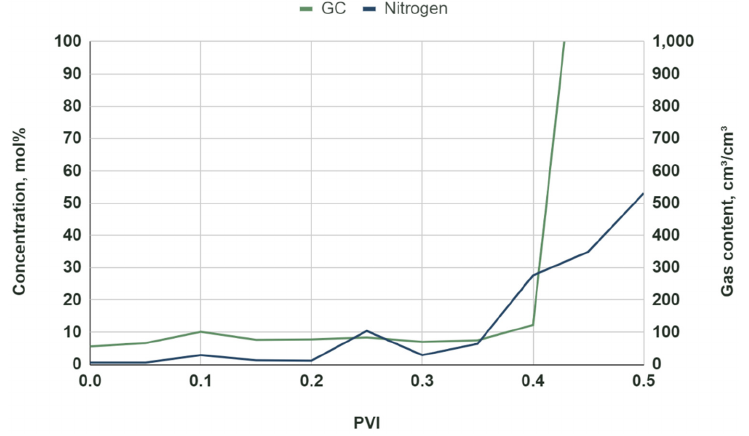
Figure 8. Nitrogen concentration in produced gas, for Nitrogen injection at pressure of 40 MPa.